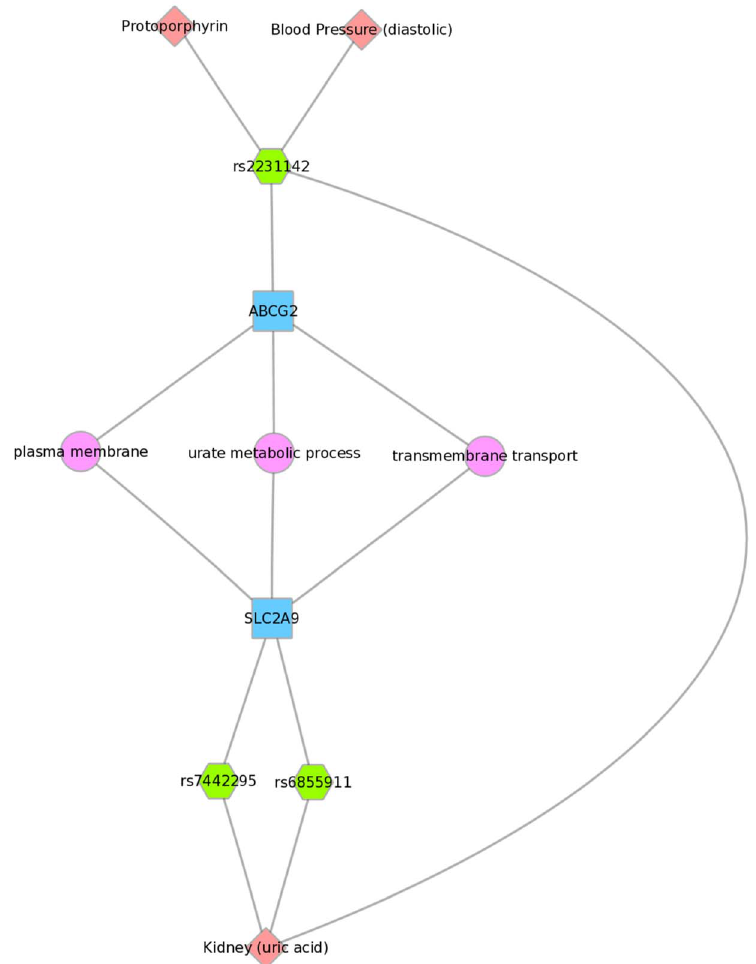
Fig. 9. Using PheWAS results, Biofilter, and Cytoscape to explore gene-gene connections with GO biological processes. Three SNPs were associated with uric acid levels in Mexican Americans: rs2231142, rs7442295, rs685911 (green hexagons). One of the SNPs is within the gene ABCG2 , and the other two SNPs are within SLC2A9 (blue boxes). Both ABCG2 and SLC2A9 are found within the GO biological process ‘‘urate metabolic process’’, a collection of the gene products involved in the chemical reactions and pathways involving urate. This was also found for non-Hispanic whites.